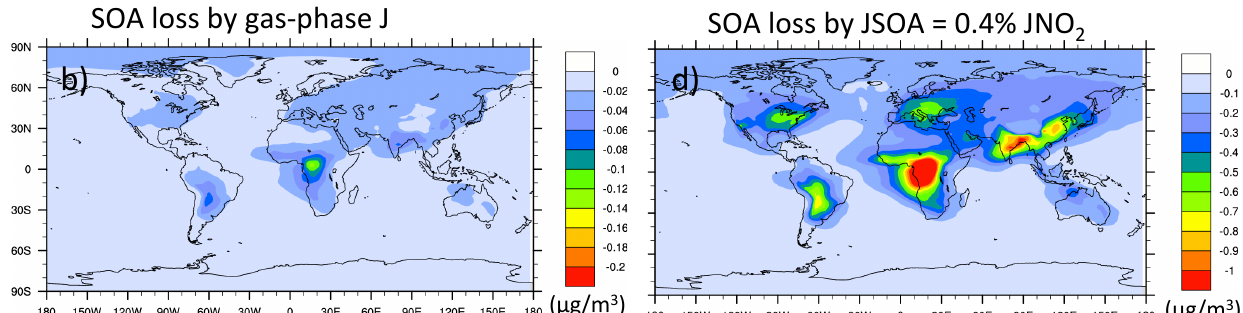
(left side) and J SOA of 0.4% J NO (right 2 2